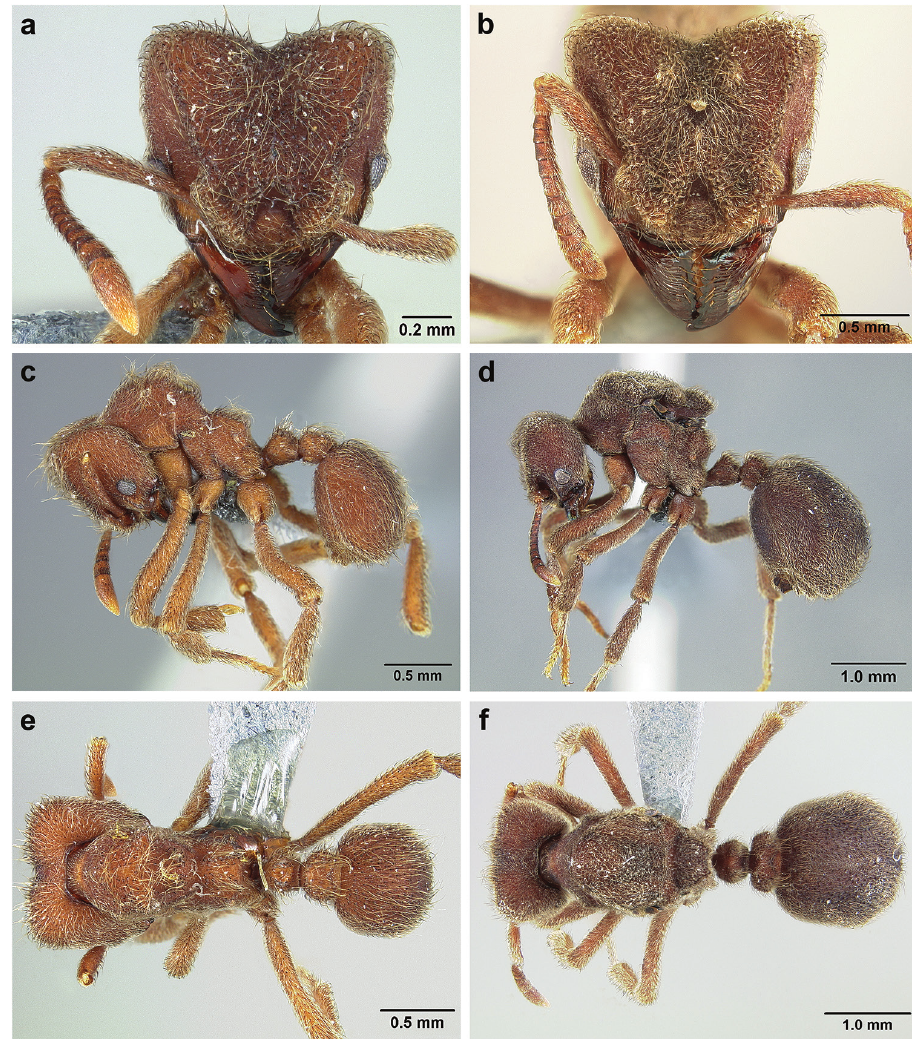
Figure 53. S. saramama worker (USNMENT00924064) and queen (USNMENT00924065); head, pro- file and dorsal views. Worker: a , c , e . Queen: b , d , f . slightly convex, without white layer, 7–9 ommatidia across largest diameter. Frontal lobe moderately wide (FLI=67 ± 3), triangular, weakly directed anterad, posterior margin shorter than medial. Frontal carina not very robust, usually complete, reaching posterior cephalic corner. Antennal scape moderately long (SI=72 ± 3), sometimes almost reaching posterior cephalic